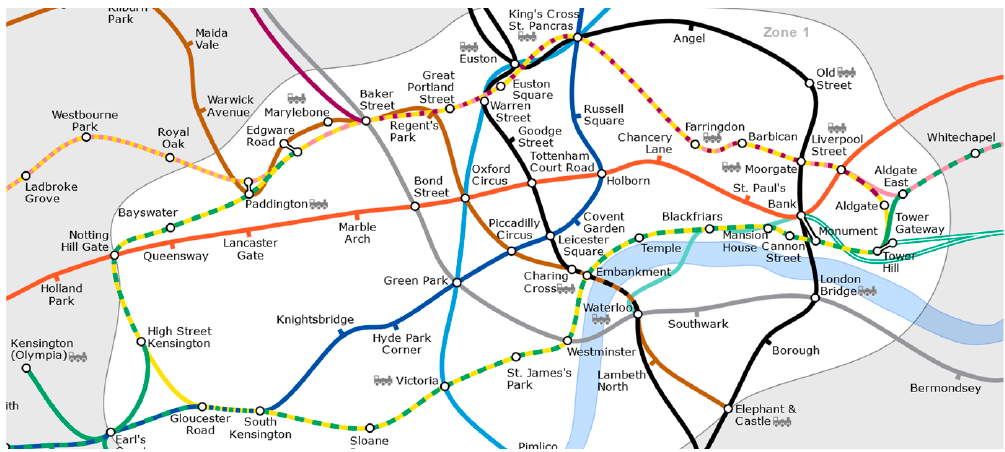
Figure 7. Map of LU lines (colored using the official palette) in Central London.